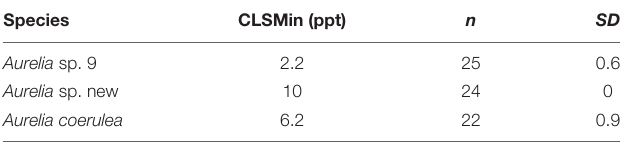
TABLE 4 | Chronic Lethal Salinity Minimum (CLSMin) for three Aurelia species. Species CLSMin